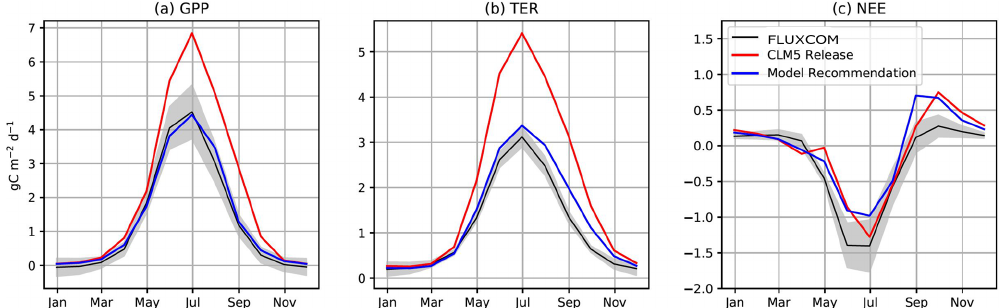
Figure 2. The annual cycle of (a) GPP, (b) TER, and (c) NEE from CLM5.0 and our model recommendation compared to FLUXCOM in the ABZ. Non-productive grid cells in the ABZ are removed from the average, meaning where LAI = 0, which is standard procedure in CLM analysis (Lawrence et al.,